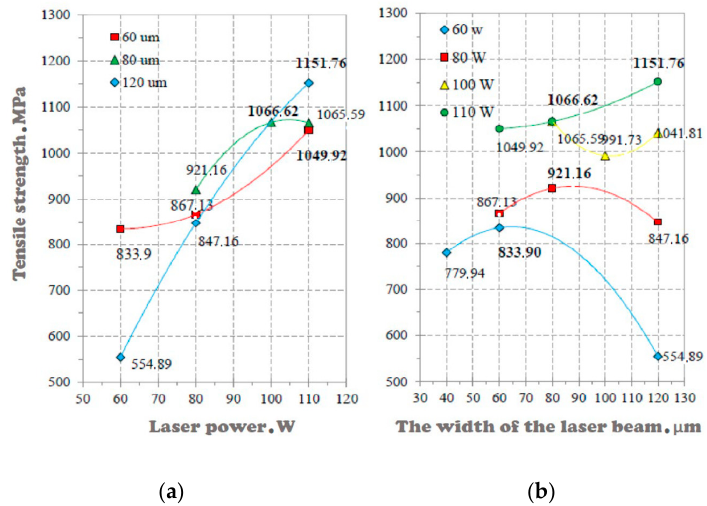
Figure 8. Relationship of tensile strength ( a ) on the laser power for different widths of the laser beam and ( b ) on the width of the laser beam for different values of the laser power. Table 5. Summary of the results of tensile and bending strength tests of the Ti6Al4V alloy manufactured by the selective laser sintering (SLS)